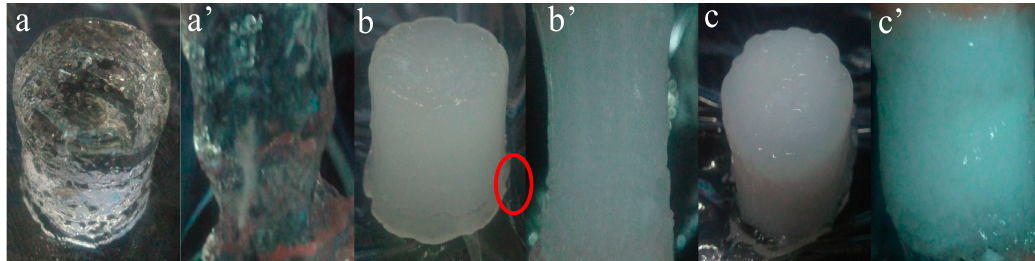
Figure 3. Morphological contrast between original samples and compressed samples (compression strain 99%); ( a ) N, ( a’ ) compressed N; ( b ) O, ( b’ ) compressed O; ( c ) P, ( c’ ) compressed P.